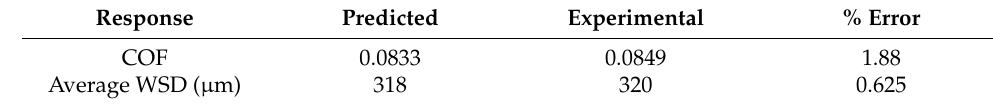
Table 9. The percentage enhancements of the COF and average WSD after adding MoS 2